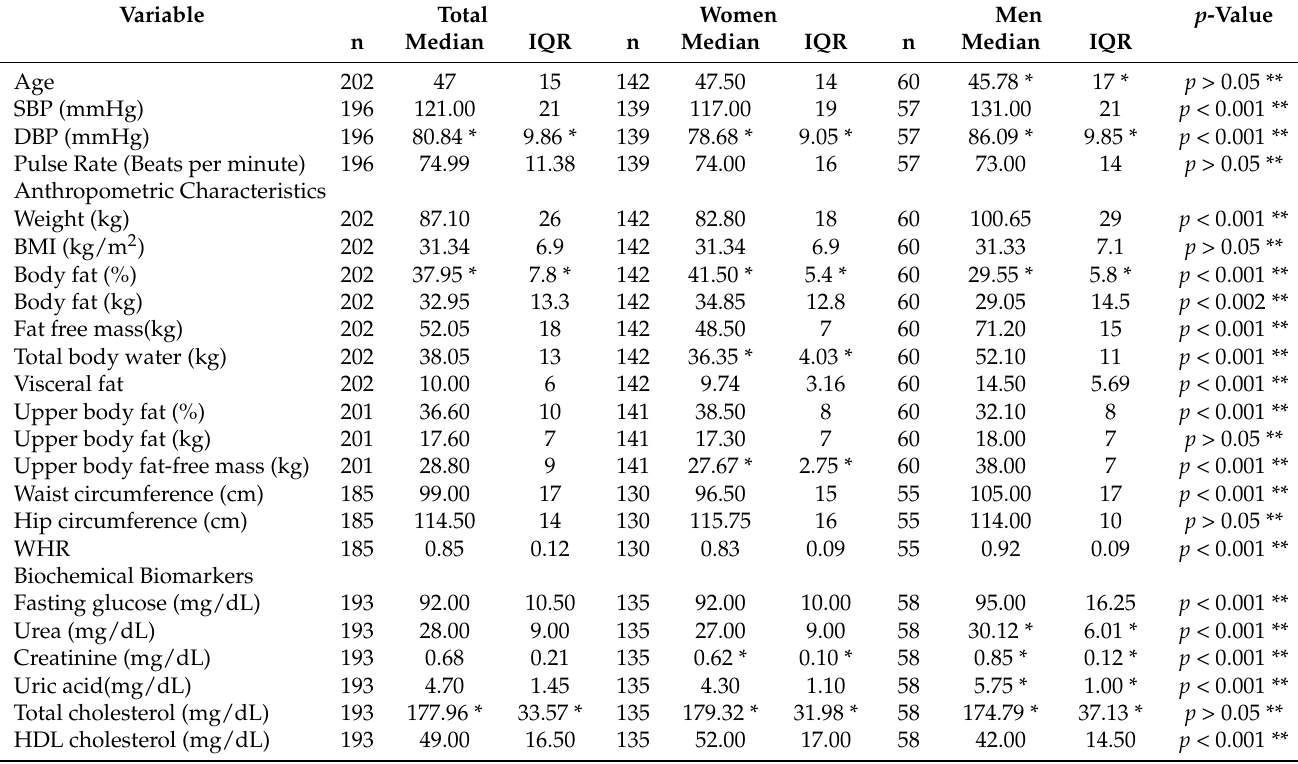
Table 2. Anthropometric, clinical, dietary characteristics and characteristics of depression, quality of sleep, and health status in the iMPROVE cohort, by